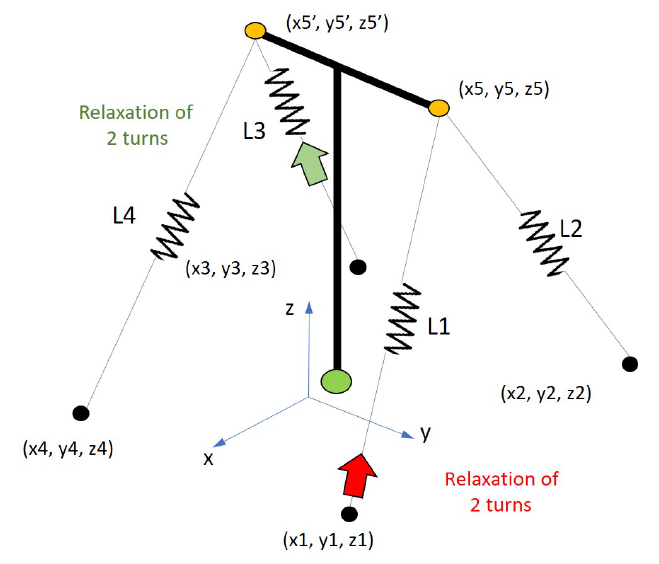
Figure 27. Case 2: load cases applied to the tower in LabEDin , simulating the relaxation of two cables simultaneously.